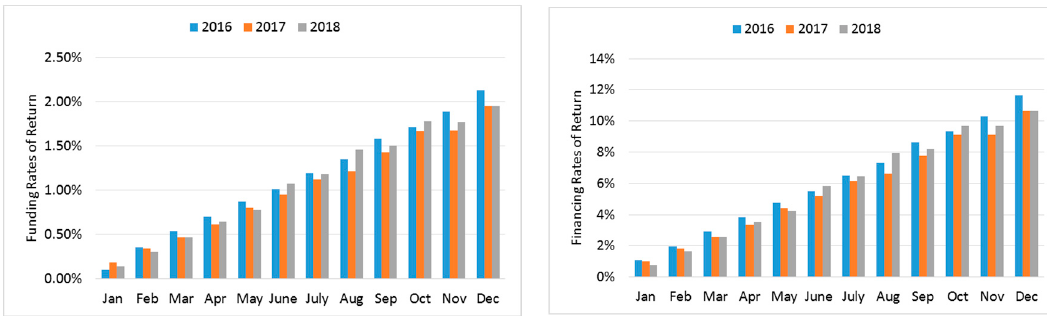
Figure A5. Rates of return for Funding ( left ) and financing ( right ) funds from Bank B.